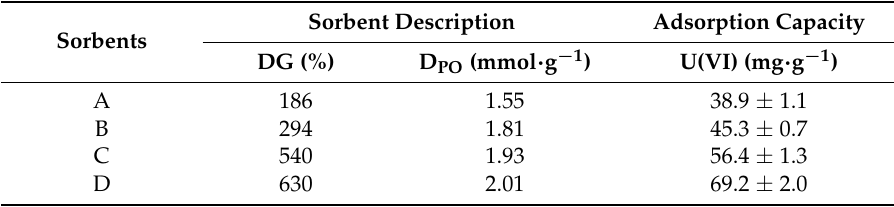
Table 1. U(VI) adsorption capacities of UHMWPE-g-PO 4 fibers with different D PO (initial U(VI) concentrations (C 0 ): 20.0 mg∙L −1 , sorbent: 0.2 g, volume: 1 L, NaF: 2.0 g∙L −1 , time: 24 h, and temperature: 25 °C).